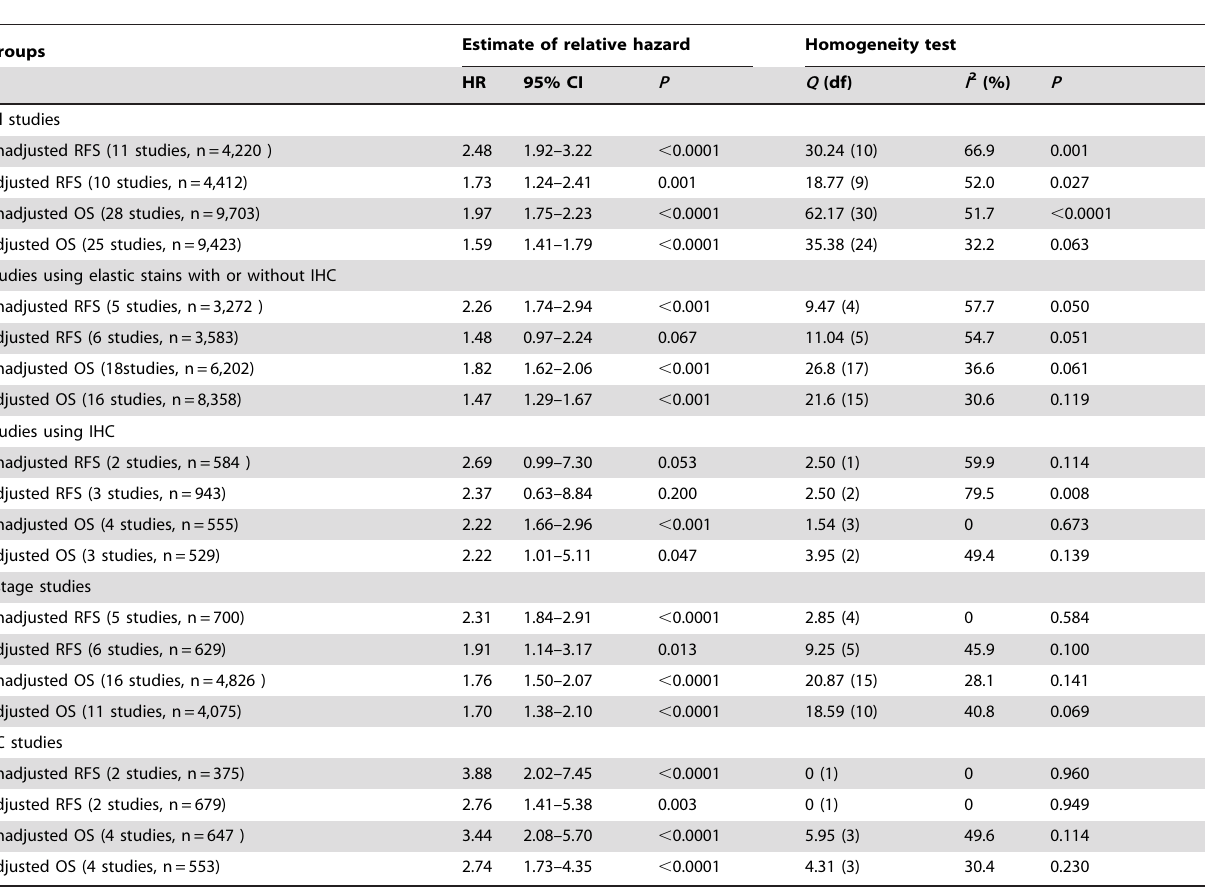
Table 2. Results of meta-analysis of LVI and survival in NSCLC